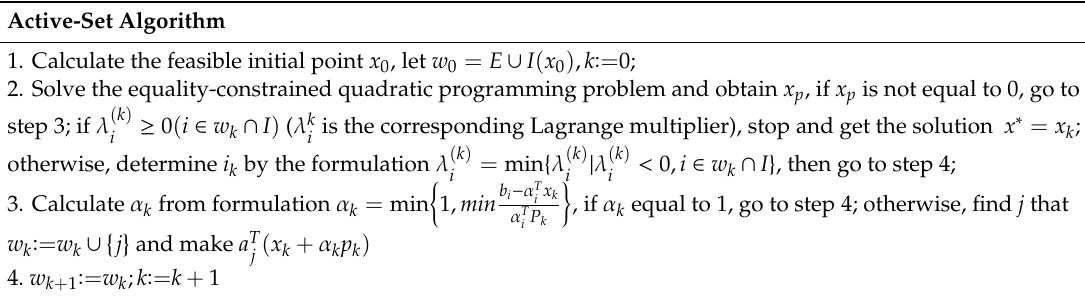
Table 1. The steps of active-set